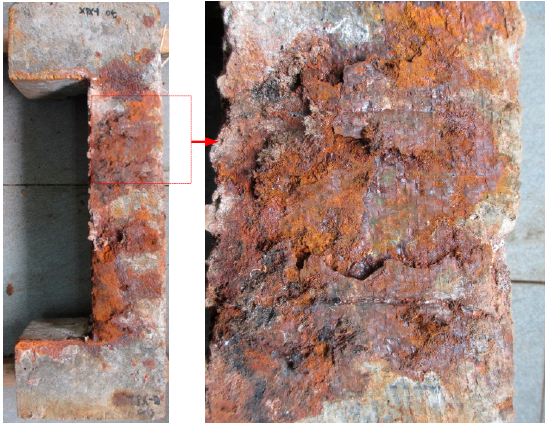
Figure 15. The damage in the RC column specimen caused by corrosion of the reinforcement.